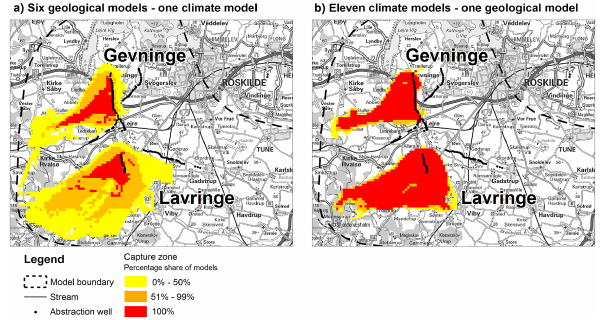
Figure 9. Uncertainty of catchment areas for two well fields us- ing (a) six geological models with the same climate model, and (b) 11 climate models with the same geological